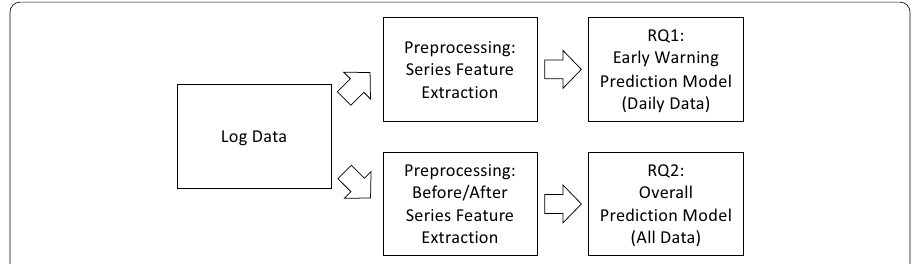
Fig. 1 Overview of the data analysis